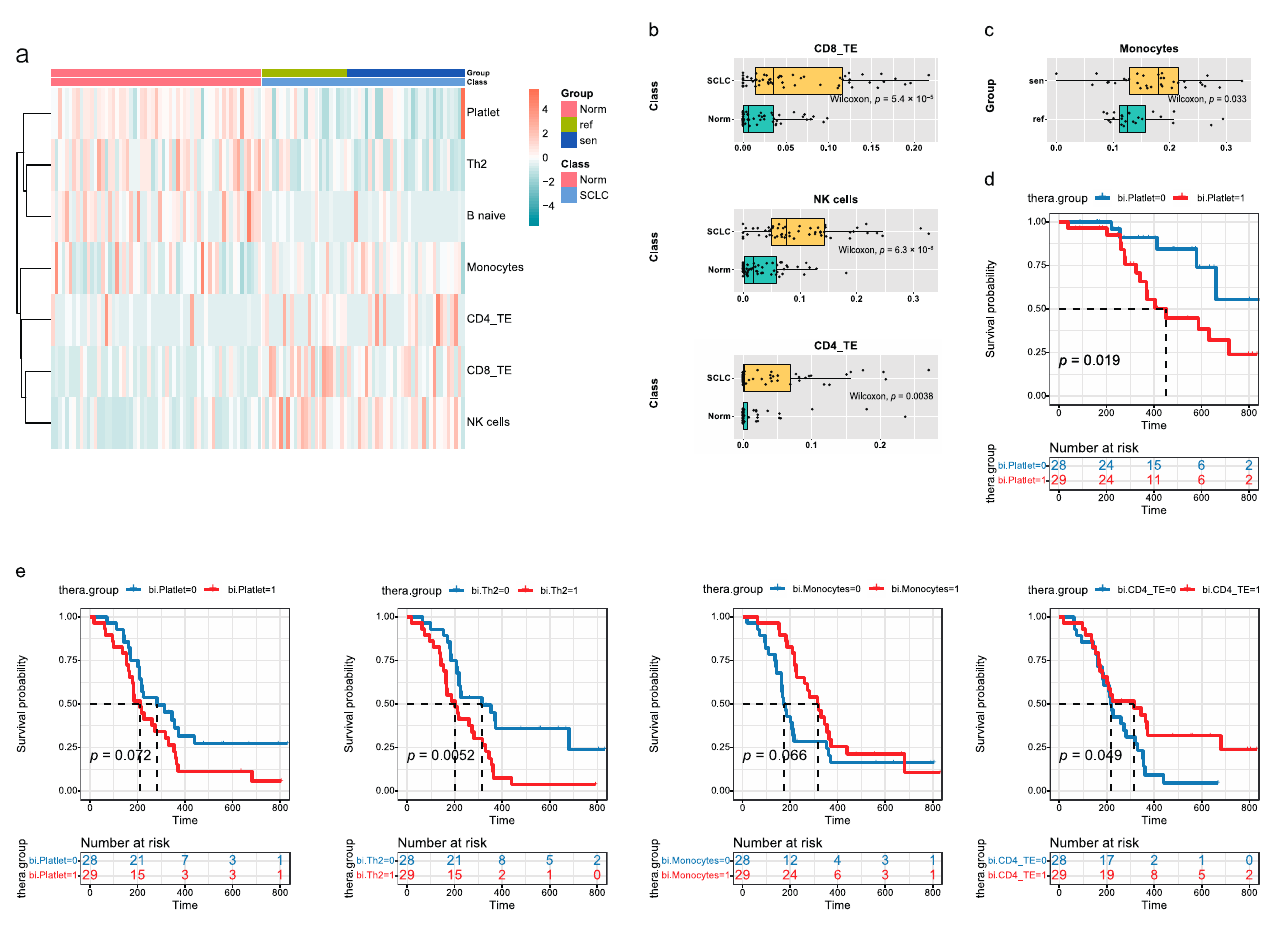
Figure 3. Comparison of different cell types from the exLR-seq data. ( a ) Heatmap of hierarchical clustering of cell types differentially observed in different groups. Boxplots of cell-type abundance between healthy controls and SCLC ( b ) and between chemo-refractory and chemo-sensitive groups ( c ). Prognostic significance of cell types by OS ( d ) and PFS ( e ). OS: overall survival; PFS: progressive free survival.